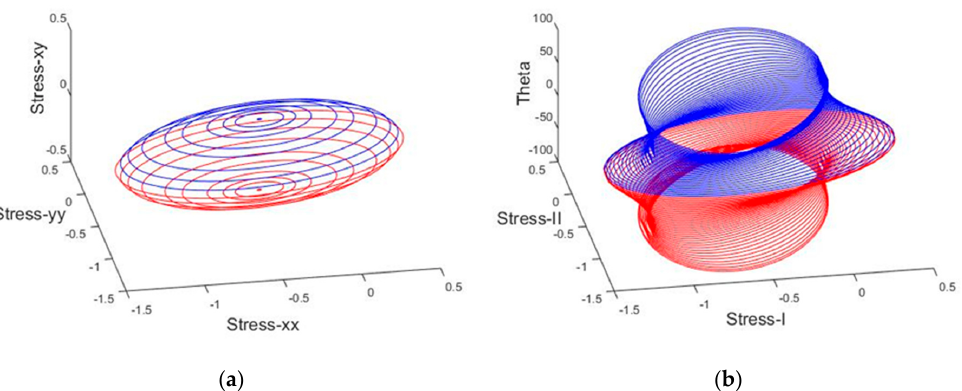
Figure 3. Non-dimensionless failure surface of masonry material using the simplified failure criterion: ( a ) non-dimensionless normal stress terms; ( b ) non-dimensionless principal stress terms. Table 1. Minima and maxima for both failure criteria/surfaces.